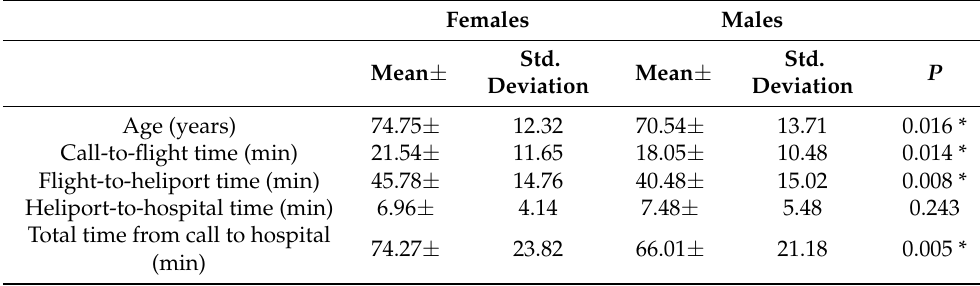
Table 2. Differences between females (n = 67) and males (n = 155) in age and transportation times; Student’s t test for independent samples, one-tailed.